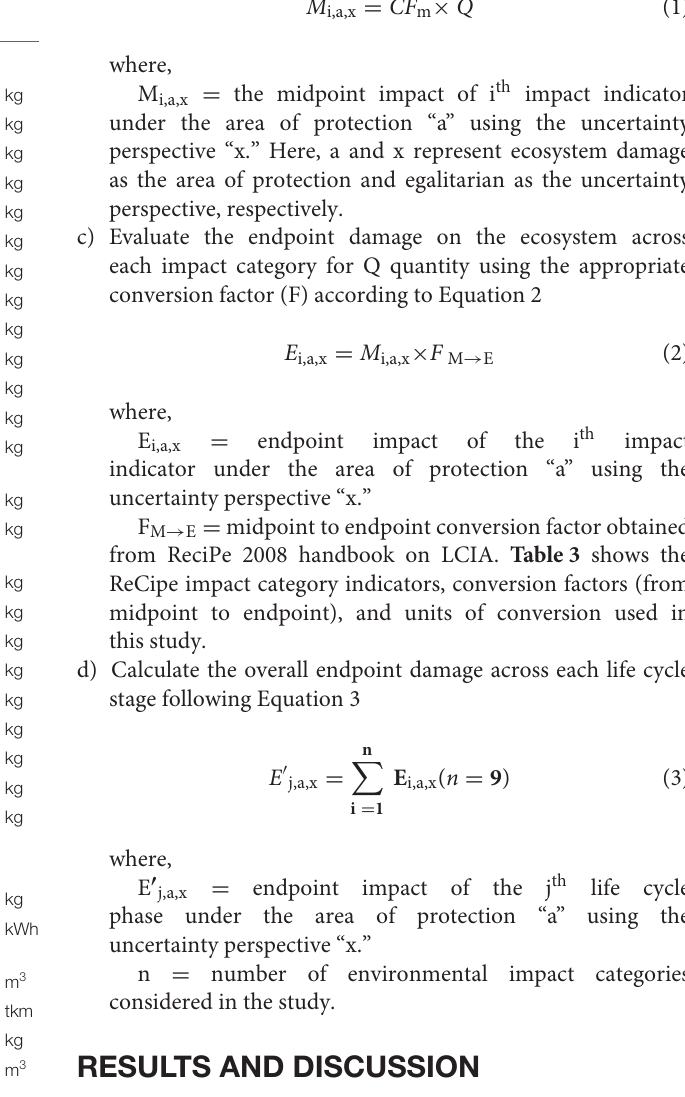
TABLE 2 | Life cycle inventory data of Ras Abu Aboud Stadium. Materials/activities